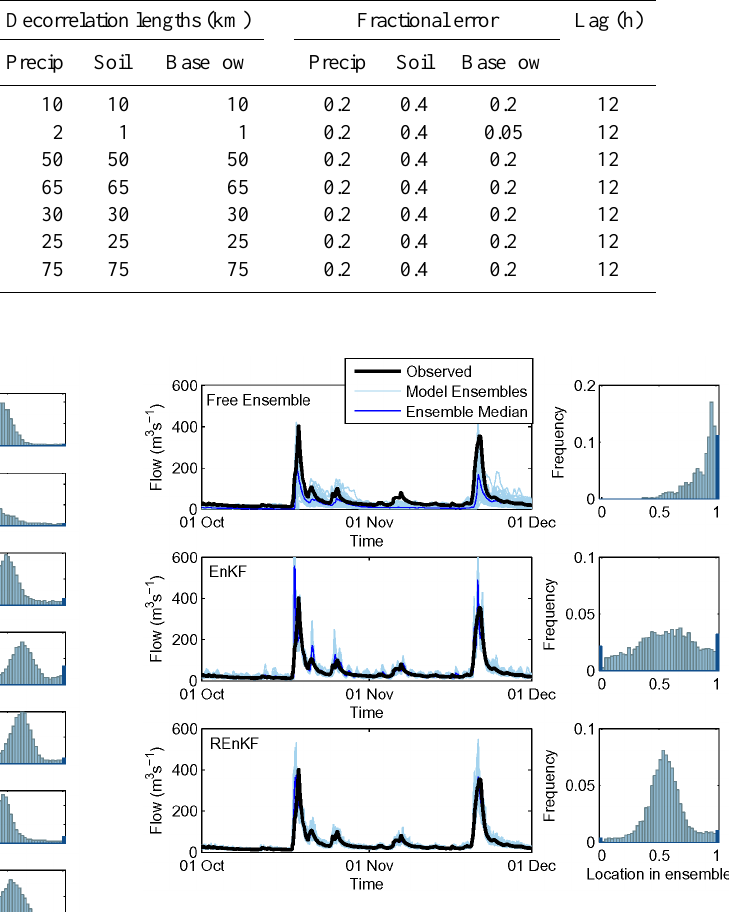
Fig. 7. Simulations for the Pomahaka catchments showing (left pan- els) ensemble simulations for a 2-month period 1 October 2011– 1 December 2011, (right panels) rank histograms of location of measured flow within the model ensemble, calculated for the year 1 April 2011–31 March 2012. Dark bars at locations 0/1 show ob- servations outside the model ensemble. The rows represent (upper panels) free running ensemble with no assimilation, (middle panels) EnKF assimilation, (lower panels) REnKF